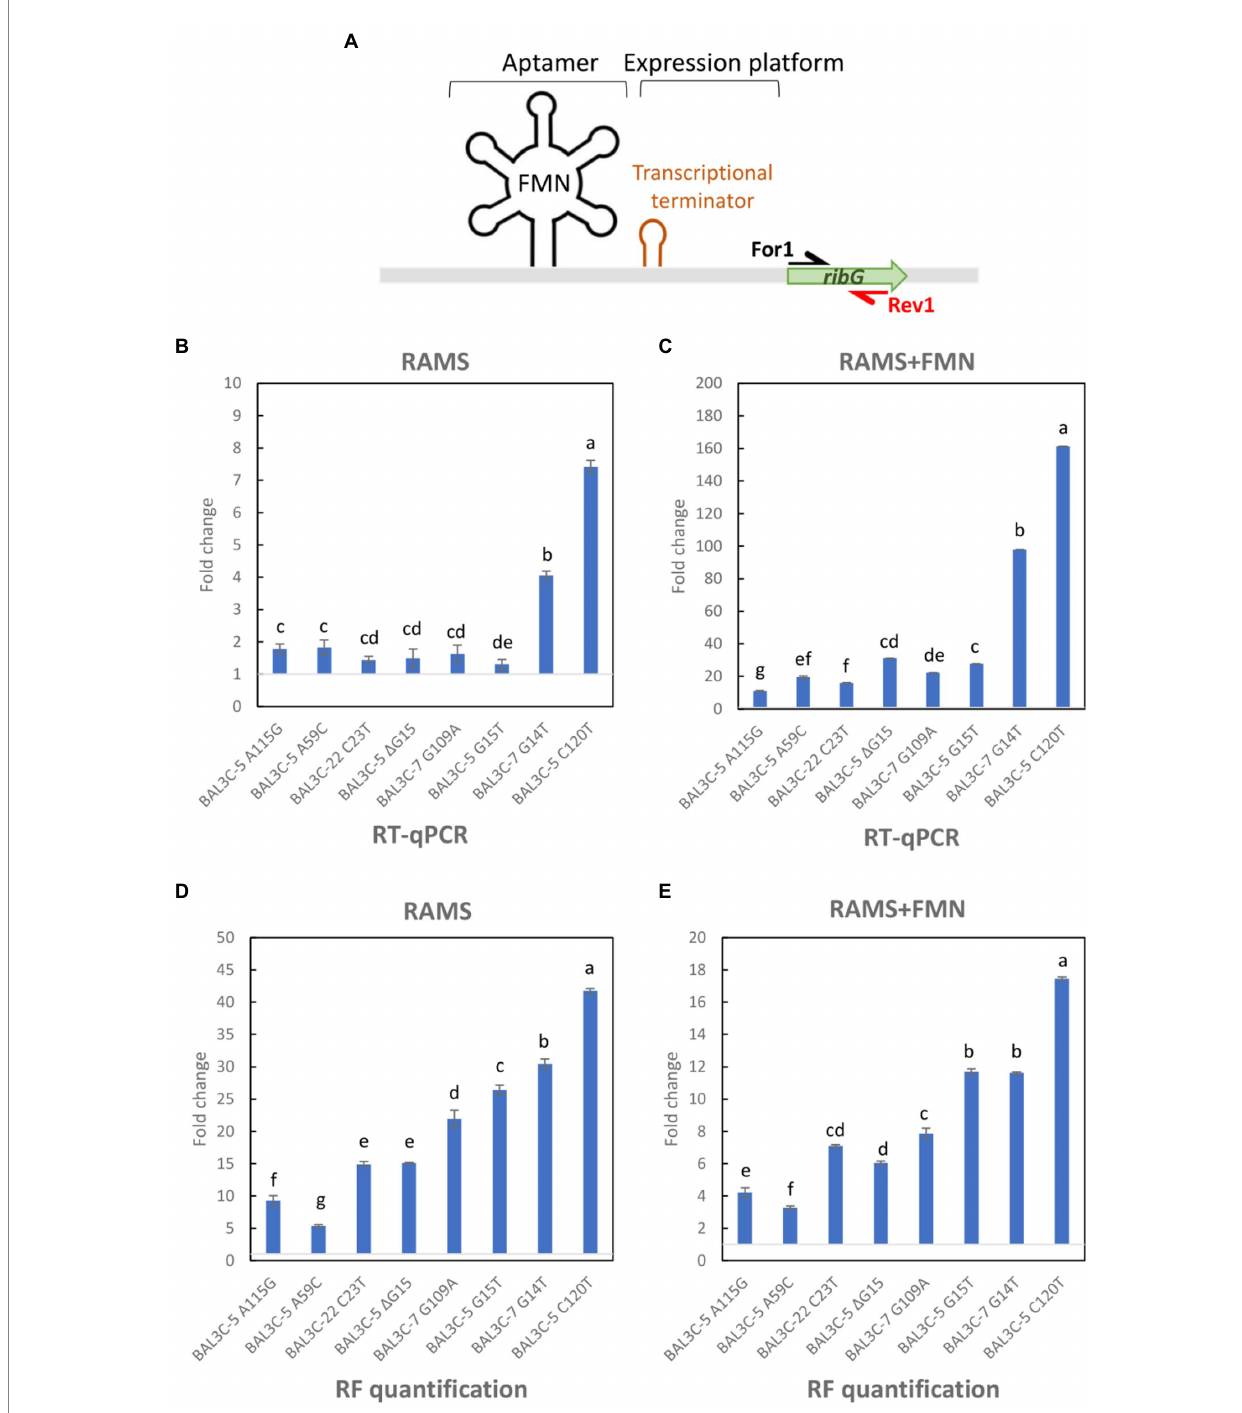
FIGURE 7 RT-qPCR analysis of ribG gene expression and evaluation of RF levels in Weissella cibaria cultures grown in RAMS or RAMS + FMN. (A) Schematic representation of the rib operon riboswitch including the FMN binding sensing aptamer and the expression platform in which a transcriptional terminator is formed in presence of FMN. The name and location of the primers used for the analysis are indicated. (B,C) Fold change of ribG gene expression in mutant strains compared with parental strains grown in RAMS (B) or RAMS + FMN (C) . (D,E) Fold change of RF production by mutant strains with regard to parental strains quantified from cultures submitted to RT-PCR in RAMS (D) or RAMS + FMN (E) . Different letters mean statistically significant difference ( p ≤